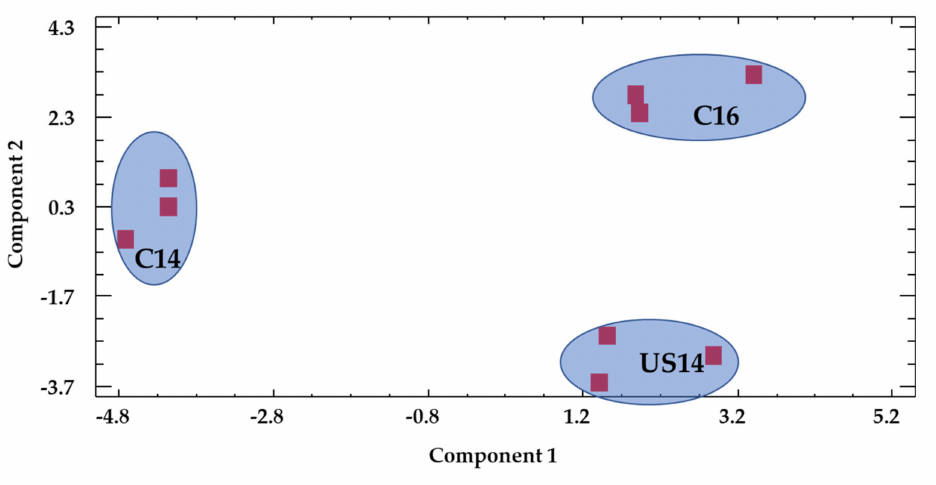
Figure 2. Distribution of the di ff erent wine samples in the plane defined by the two first principal